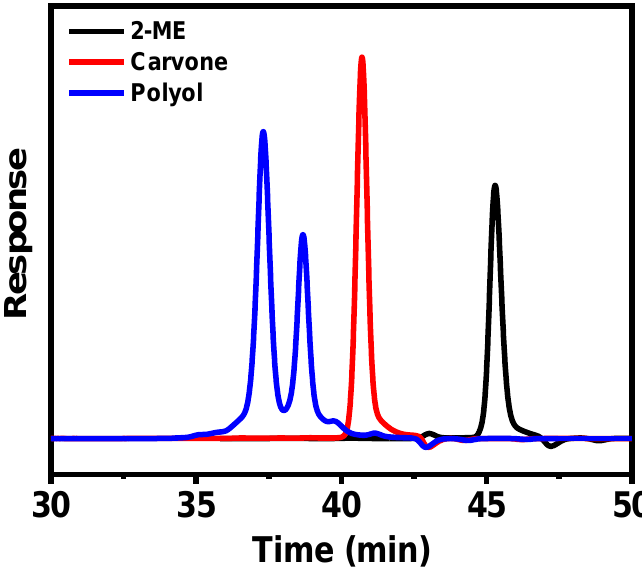
Figure 2. Gel Permeation Chromatogram for carvone, 2-mercaptoethanol (2-ME), and carvone-based polyol.